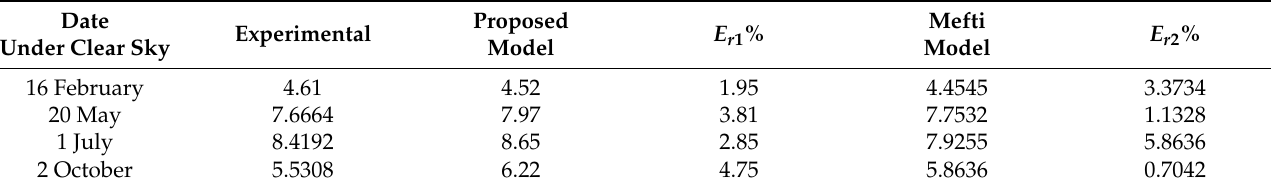
Table 8. Results for Senia site (KWh/m 2